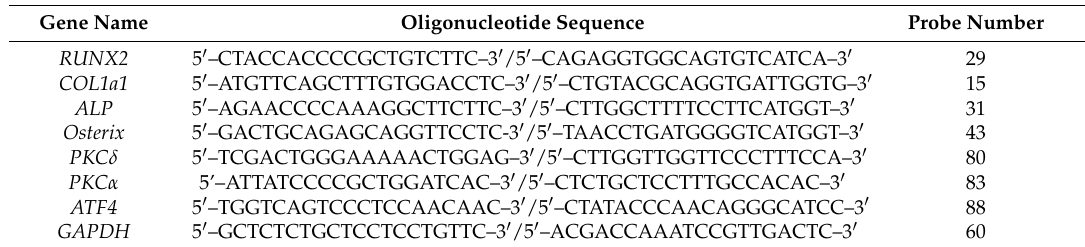
Table 1. Primer sequences and probes from the Universal Probe Library used for